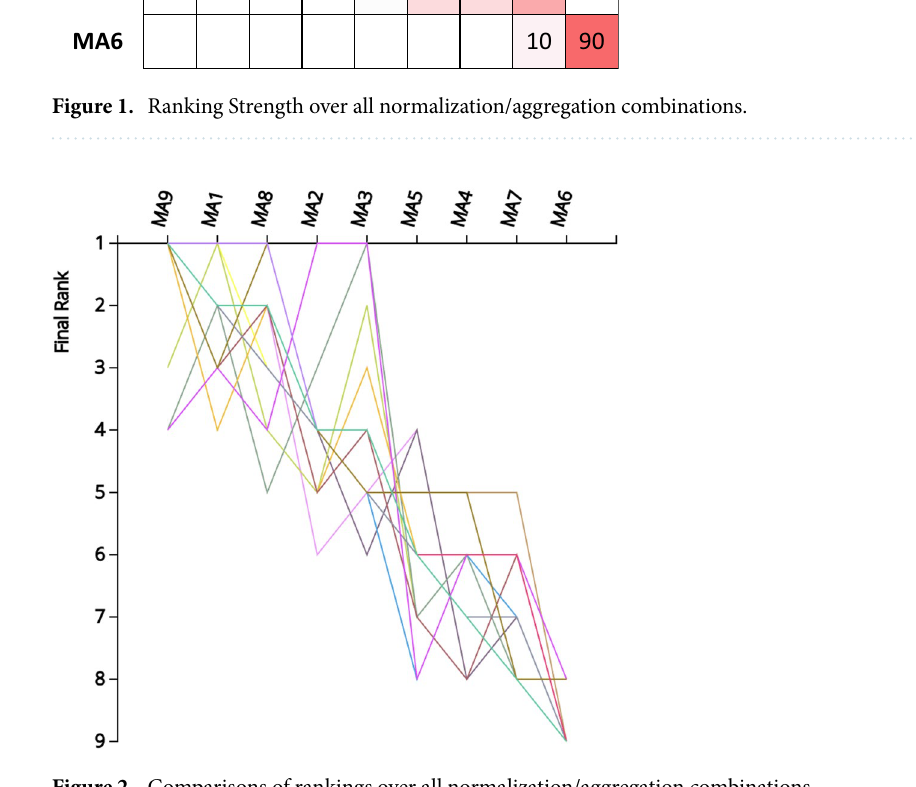
Figure 2. Comparisons of rankings over all normalization/aggregation